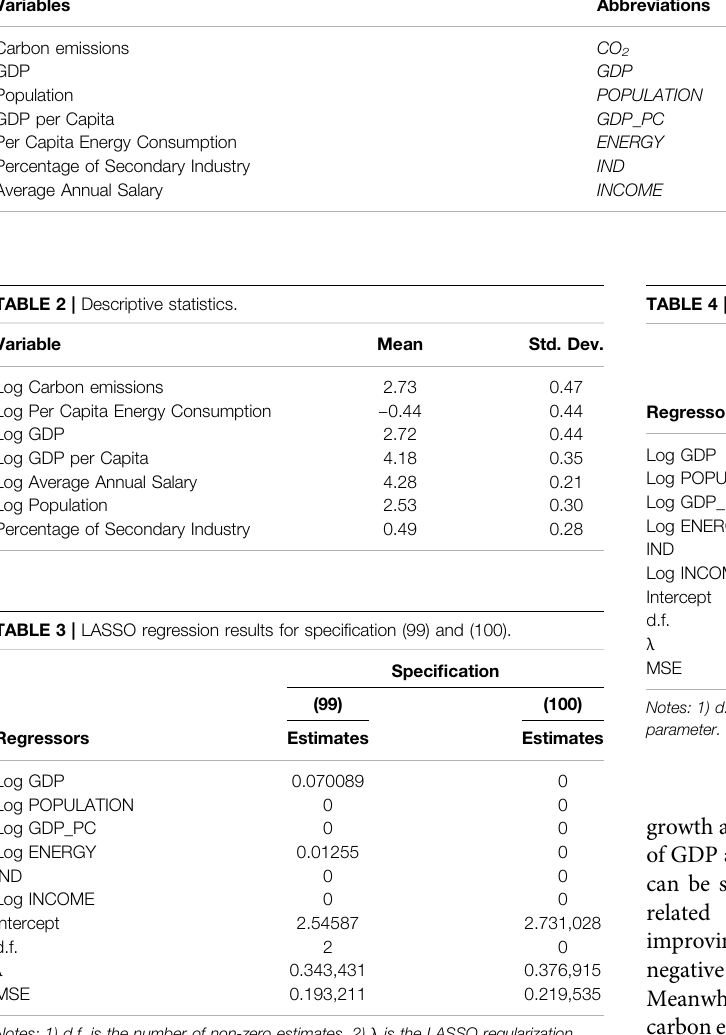
Table 2 below and this is a strongly balanced panel dataset, which will show us more robust results. Table 3 presents the LASSO regression results for